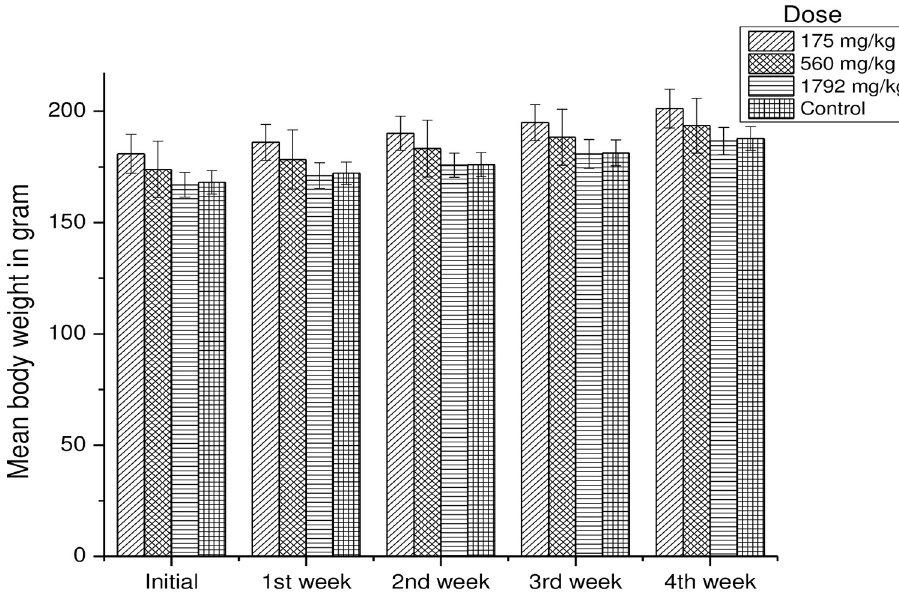
Fig 8. Mean body weight change in rats treated with 175 mg/kg, 560 mg/kg, and 1792 mg/kg of PDAS (DS = 2.842) in distilled water as compared to the control group during the subacute toxicity study.